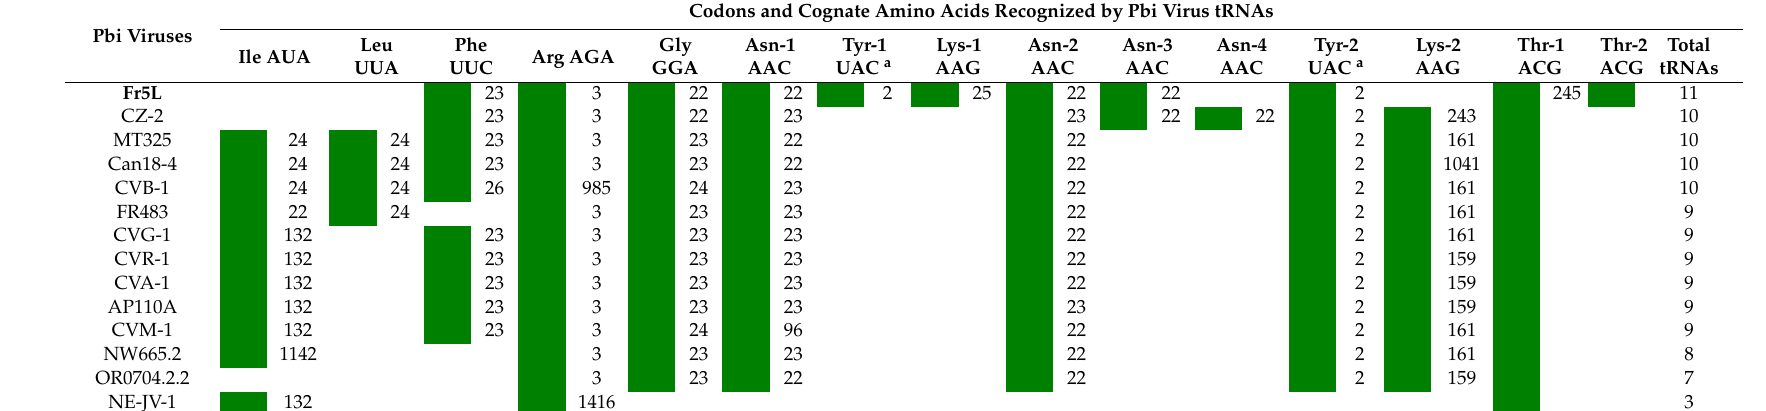
Table 3. The order of clustered tRNA genes in Pbi chloroviruses 1